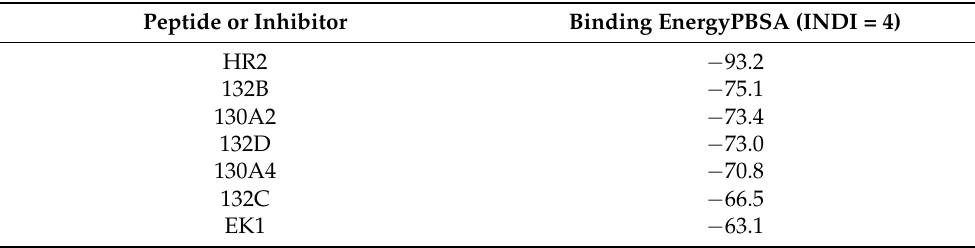
Table 3. Predicted binding affinity for top five inhibitors, HR2, and EK1 peptides to WT SARS-CoV-2 HR1